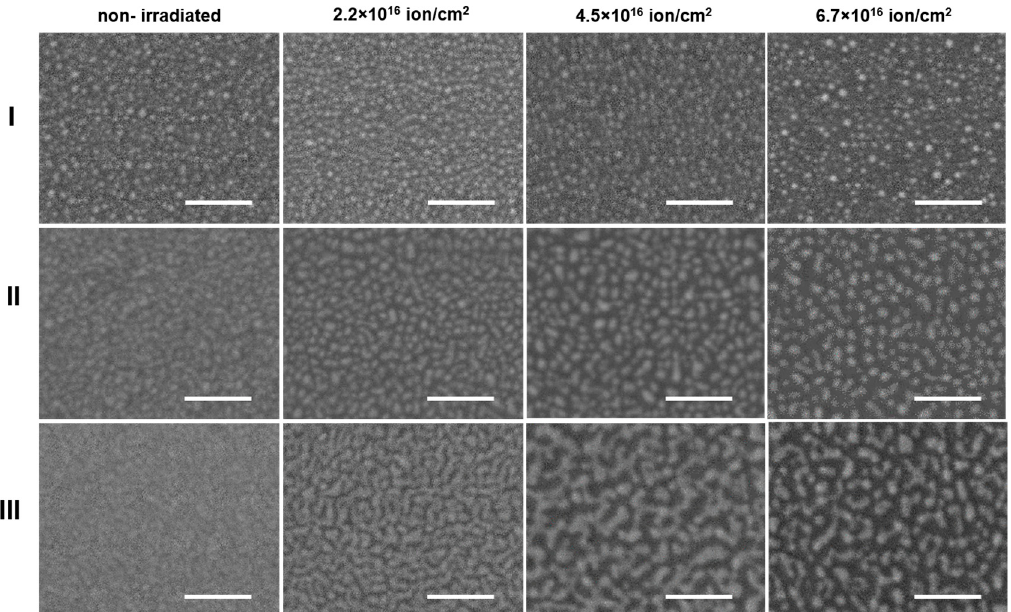
Figure 4. SEM images of Ag nanoparticles with different initial thicknesses: I-10 nm, II-20 nm and III-30 nm (shown in rows) irradiated by ion doses indicated on the top of each column. The scale bar indicates 100 nm length.